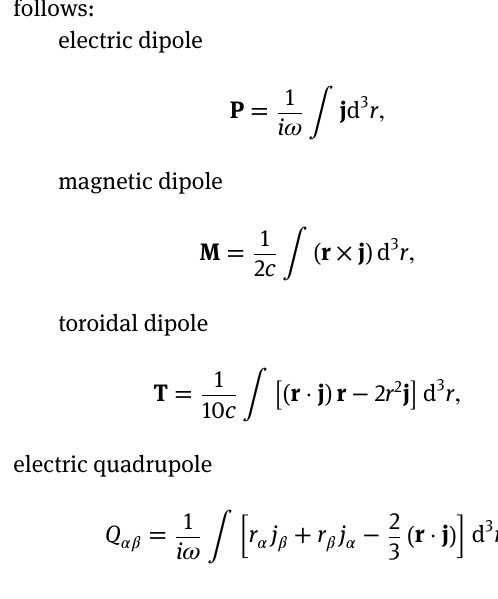
Figure 2: Biosensor sample and toroidal dipole characterization. (a) Micrograph image of the fabricated metasurface biosen- sor.(b)Unitcellofthemetasurfaceconsisting two SRRs on a dielectric slab. The structure parameters are listed as: p = 40 μ m, a = 1.5 μ m, b = 8 μ m, c = 18 μ m, g = 2.5 μ m,and w = 4 μ m. (c) Dispersion of radiation powers for different multipole moments induced in the metasurface. (d) The absorption spectrum of the toroidal metasurface and the calculated Q